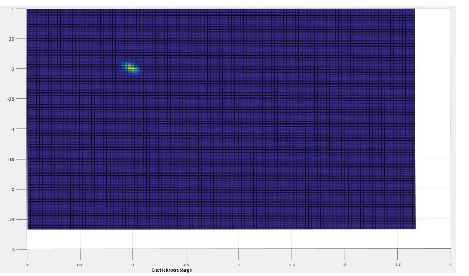
Figure 1.b. Horizontal Plot For Presentation The PDF Of “Electric Khodro Shargh”